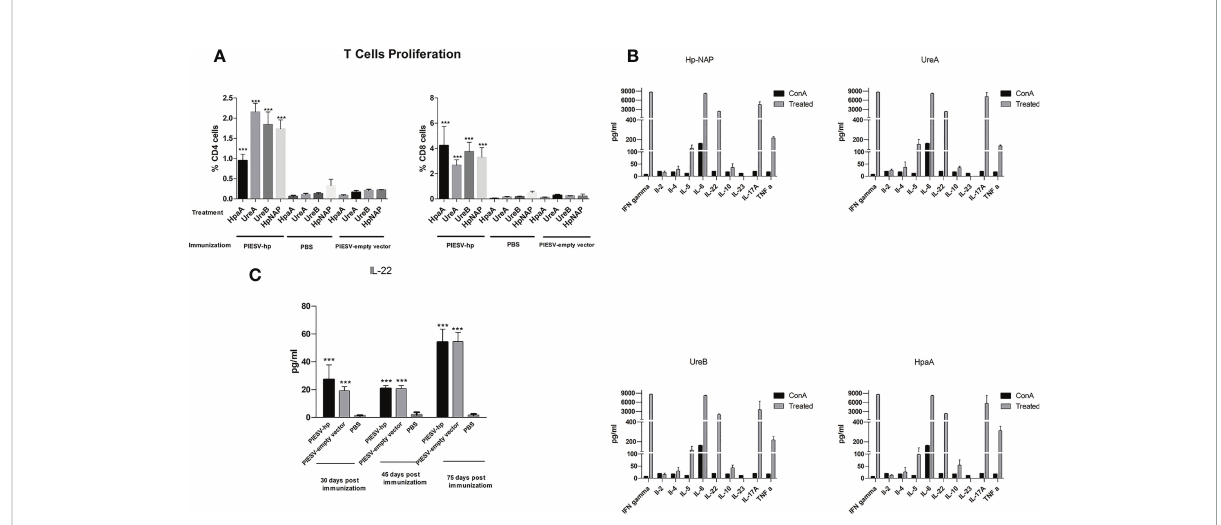
FIGURE 3 T cell responses (A) Proliferative responses of T cells from mice immunized with the c 12341(pG8R230) and c 12341(pG8R262) mixture, c 12341 (pG8R111) = PIESV-empty vector) and PBS. T cells from immunized mice were isolated 45 days post fi rst immunization and co-cultured with dendritic cells treated with 20 µg/ml recombinant NapA, HpaA, UreA and UreB and the proliferative responses were subsequently assayed by CellTrace. T cells were also stained with proper antibodies to be analyzed for the proliferation of CD4 + and CD8 + T cells by fl ow cytometry. (B) Cytokine production by T cells from mice immunized with the mixture of c 12341(pG8R230) and c 12341(pG8R262). T cells were obtained 45 days post fi rst immunization from immunized mice and co-cultured with dendritic cells already treated with 20 µg/ml recombinant NapA, HpaA, UreA and UreB. Cytokine concentrations in culture supernatants were measured by multiplex ELISA. The data are the mean ± SD of fi ve individual mice from each group. (C) . Level of IL-22 increased in mice immunized with the PIESV-Hp mixture. Sera obtained 30, 45 and 75 days after fi rst immunization of mice with PIESV-Hp, PIESV-empty vectors and PBS were analyzed for the presence of IL-22. *** P <